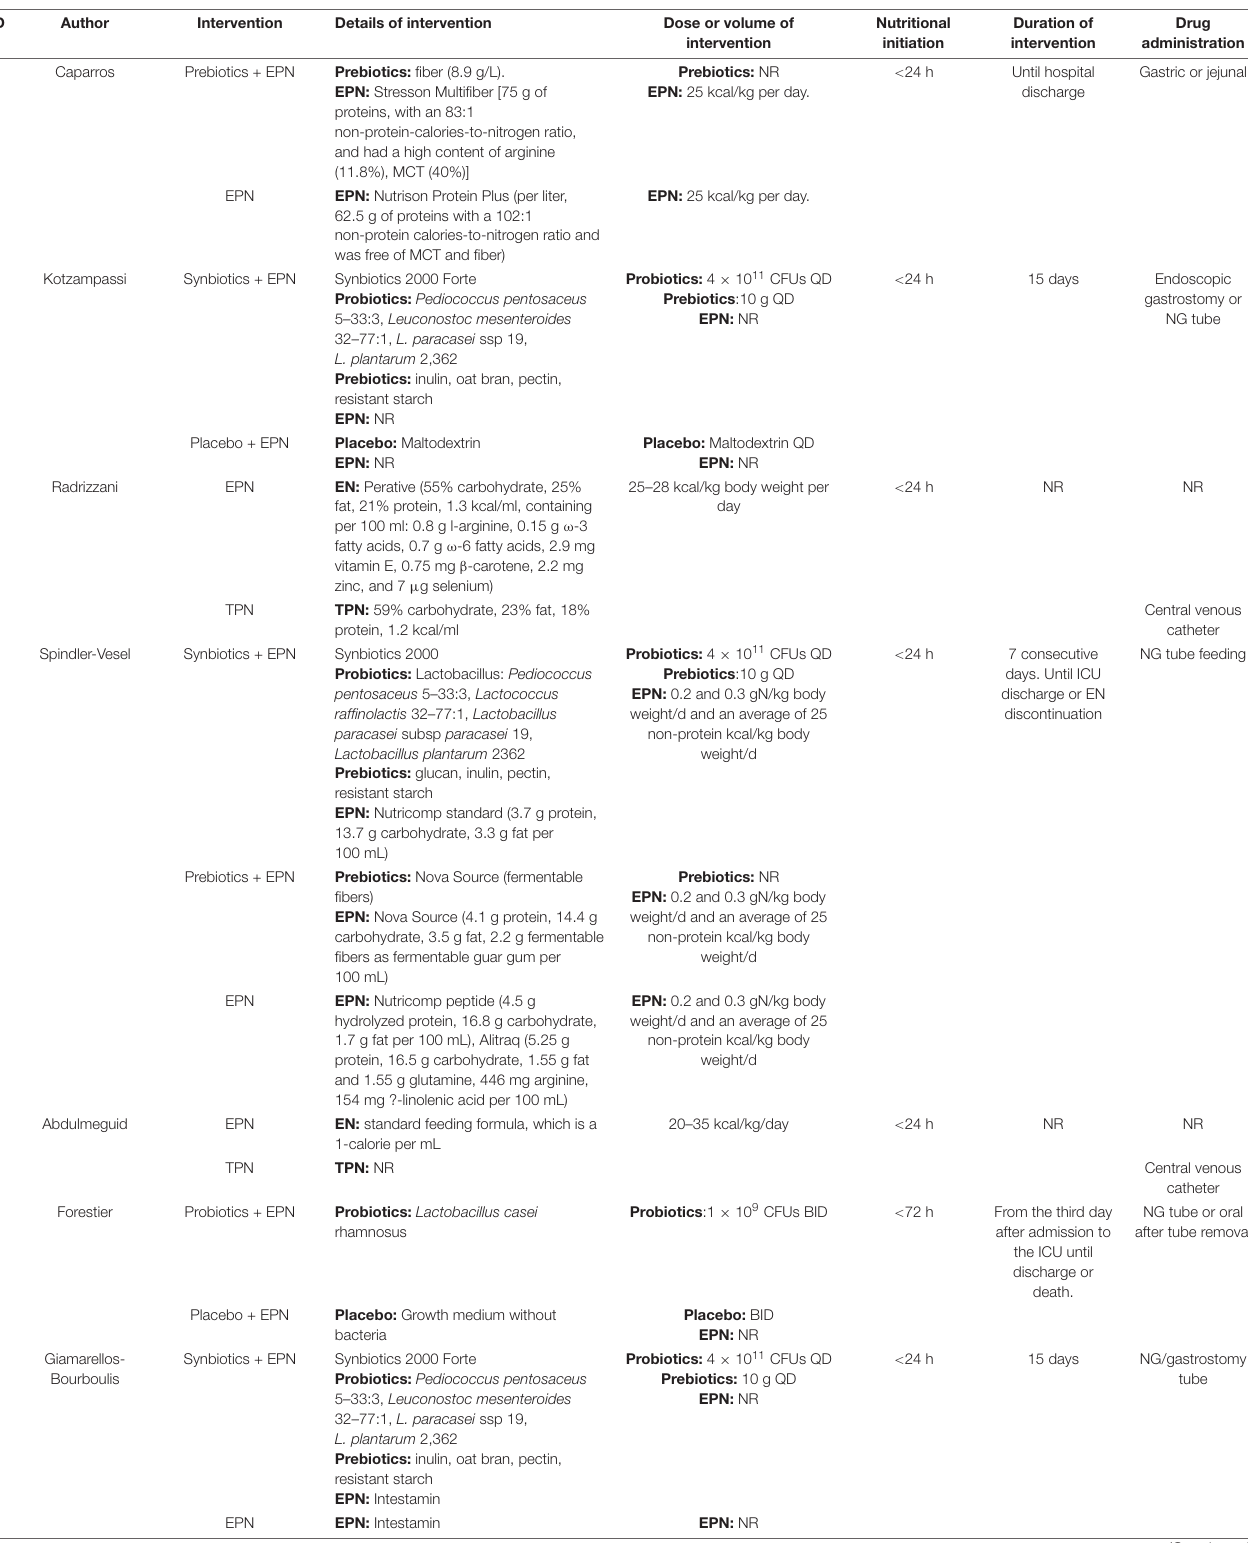
TABLE 2 | Description of included